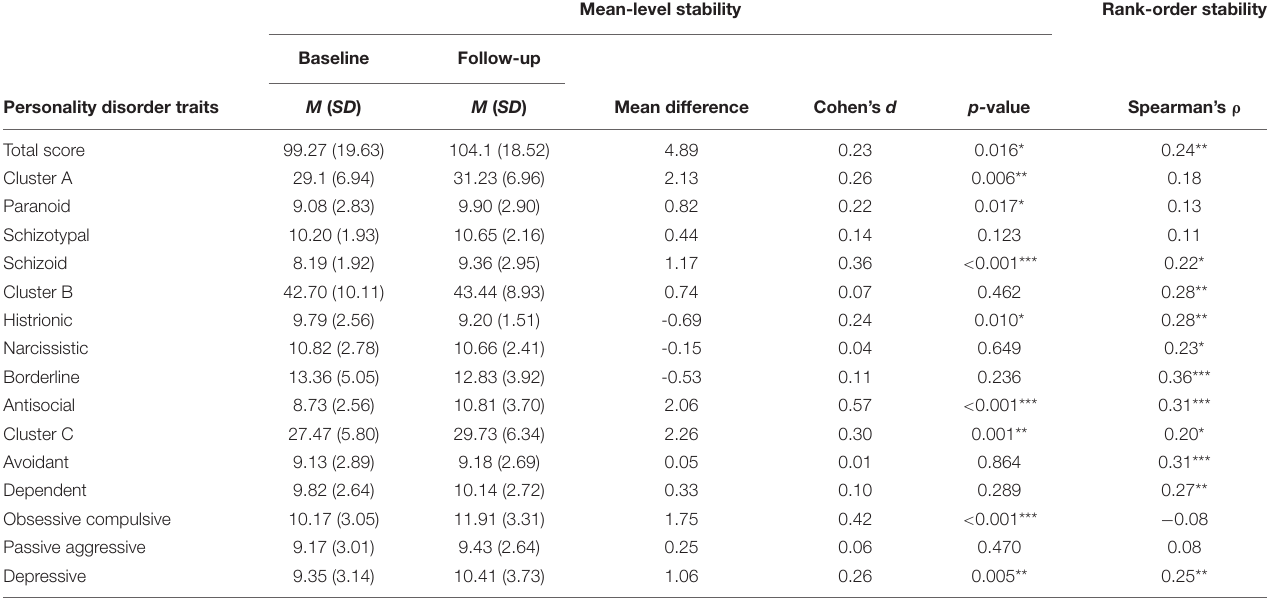
TABLE 5 | Dimensional stability of personality disorders from baseline to follow-up ( N =